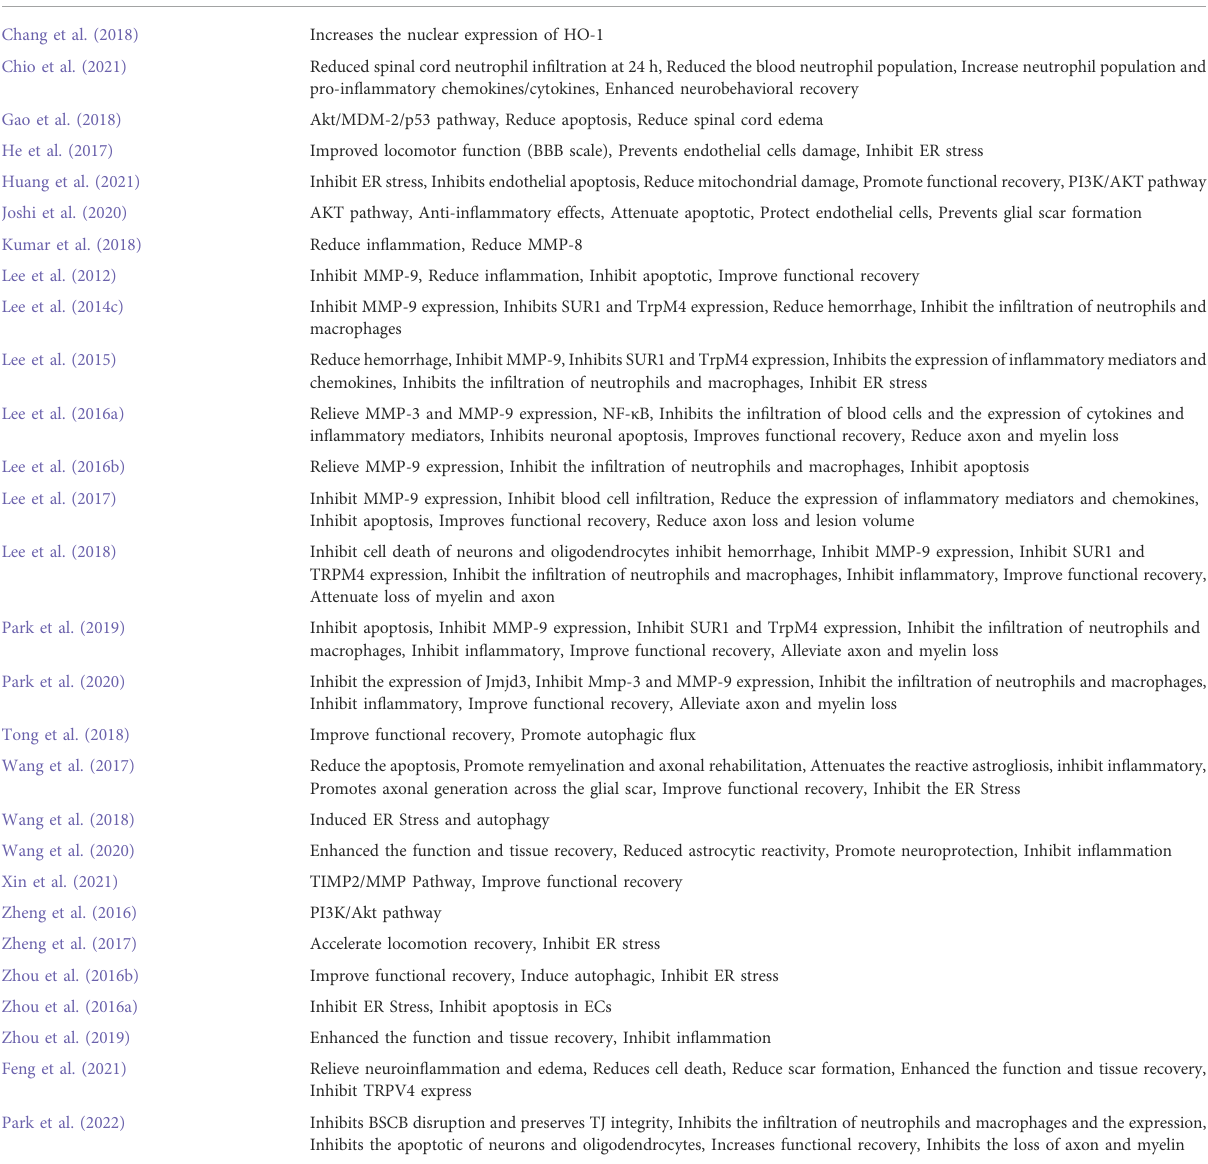
TABLE 3 Results of individual studies. Study Summary of individual outcomes included in